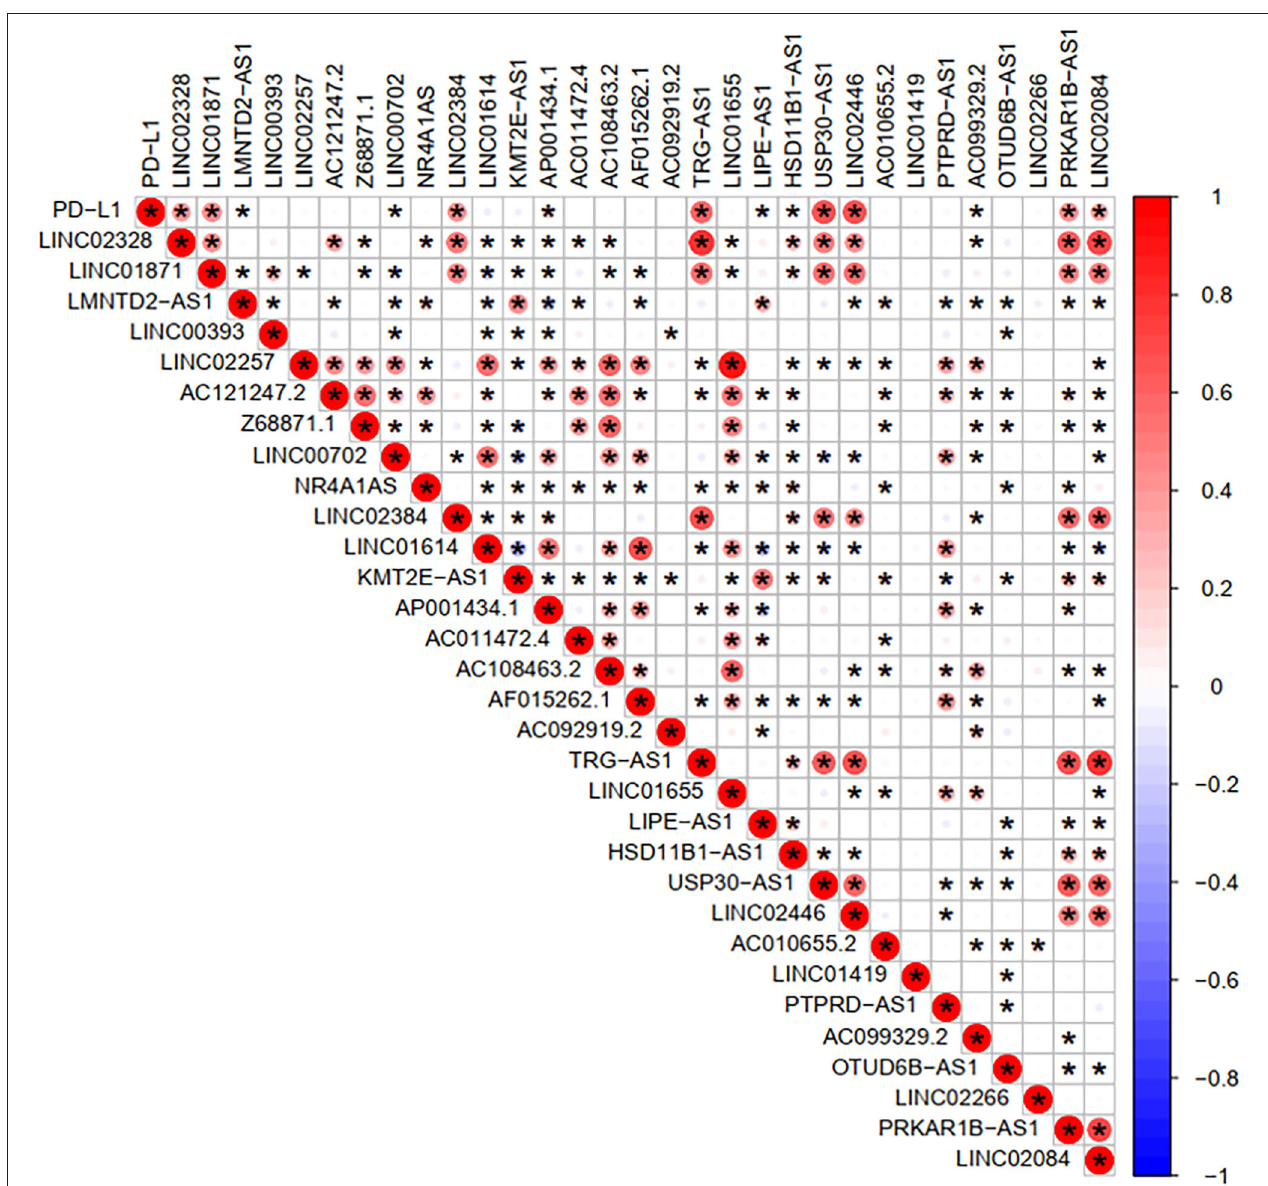
FIGURE 5 | Correlation analysis between PD-L1 gene and the prognostic FRLncRNAs. Blue is a negative correlation, red is a positive correlation, and if there is an asterisk in the grid between two genes, they are significantly correlated.